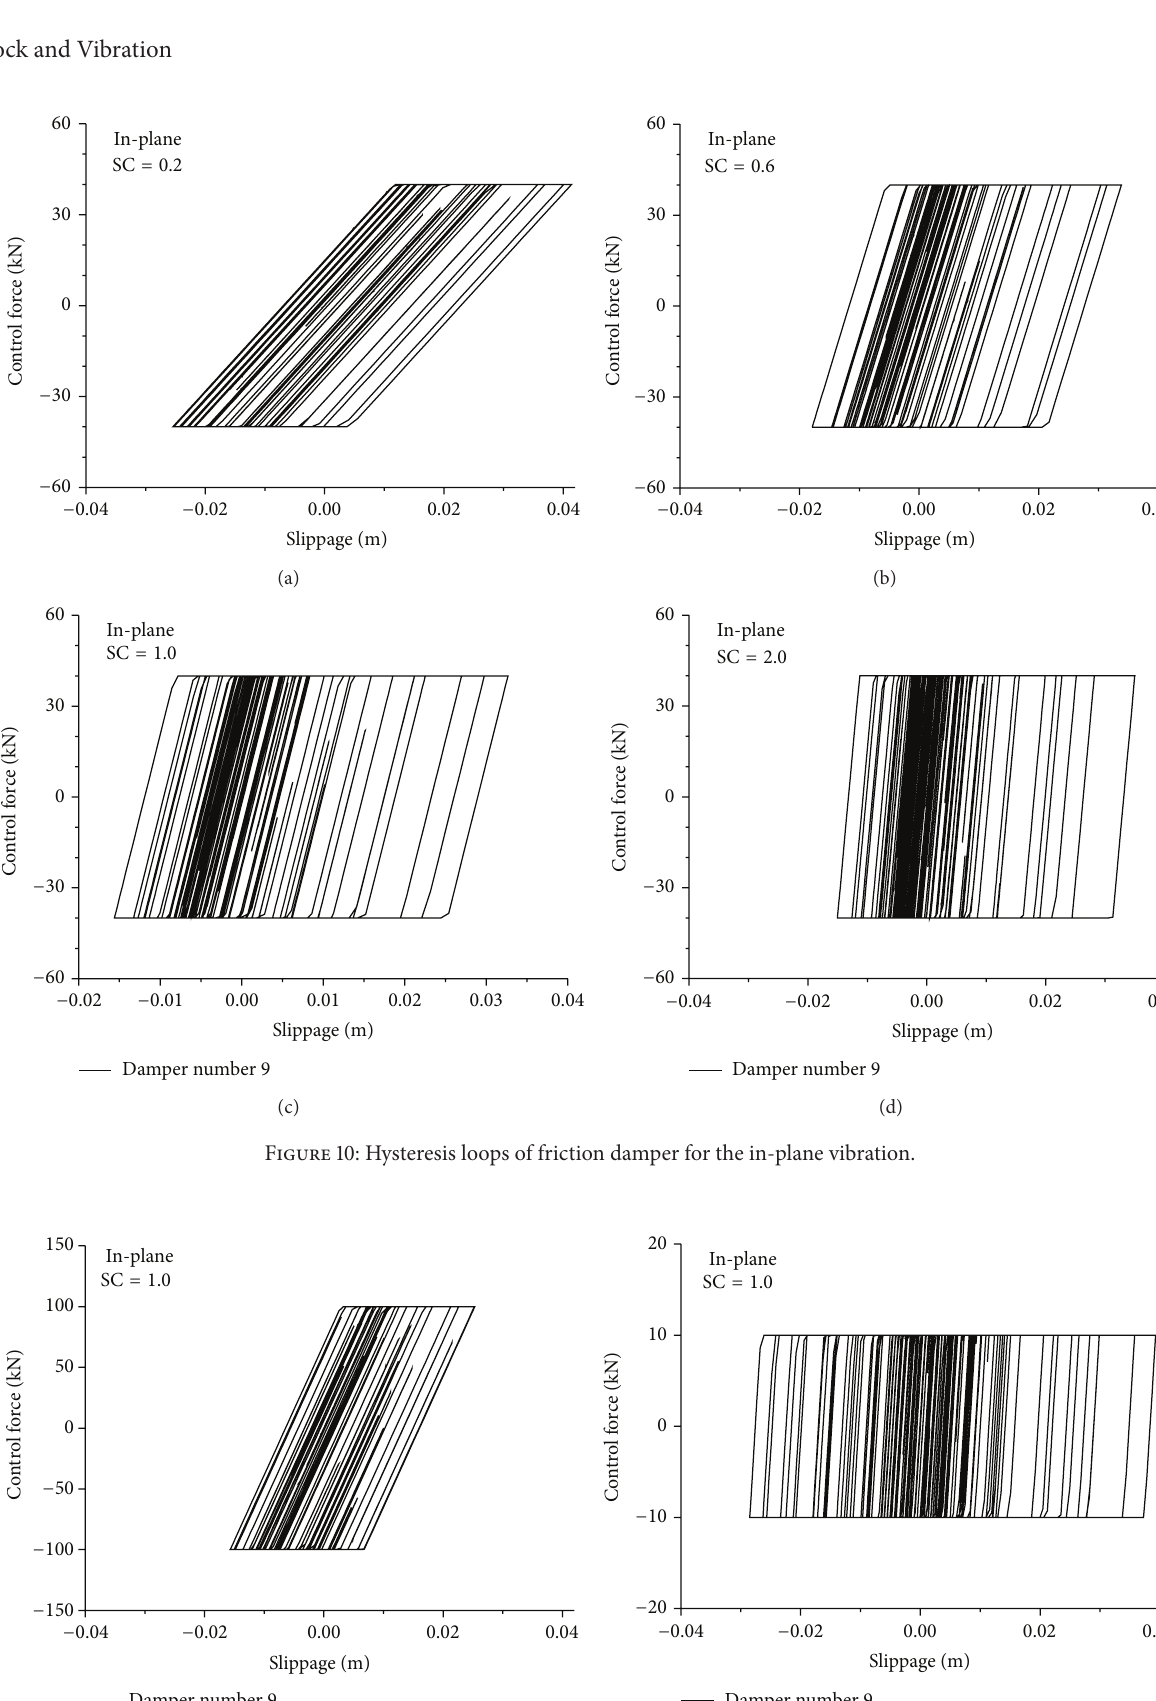
Figure 11: Comparison on hysteresis loops of friction damper for the in-plane